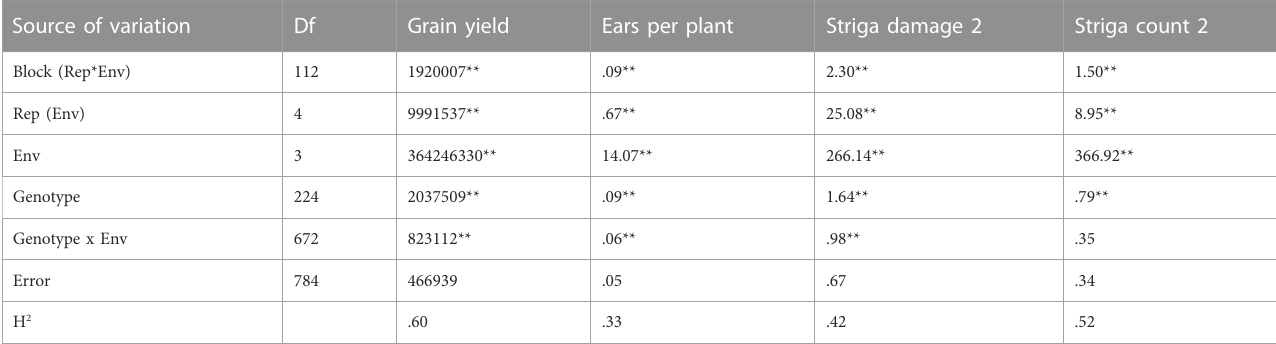
TABLE 1 Mean squares of F 2:3 mapping population evaluated under arti fi cial Striga infestation across four environments at Abuja and Mokwa in the 2019 and 2020 growing seasons. Source of variation